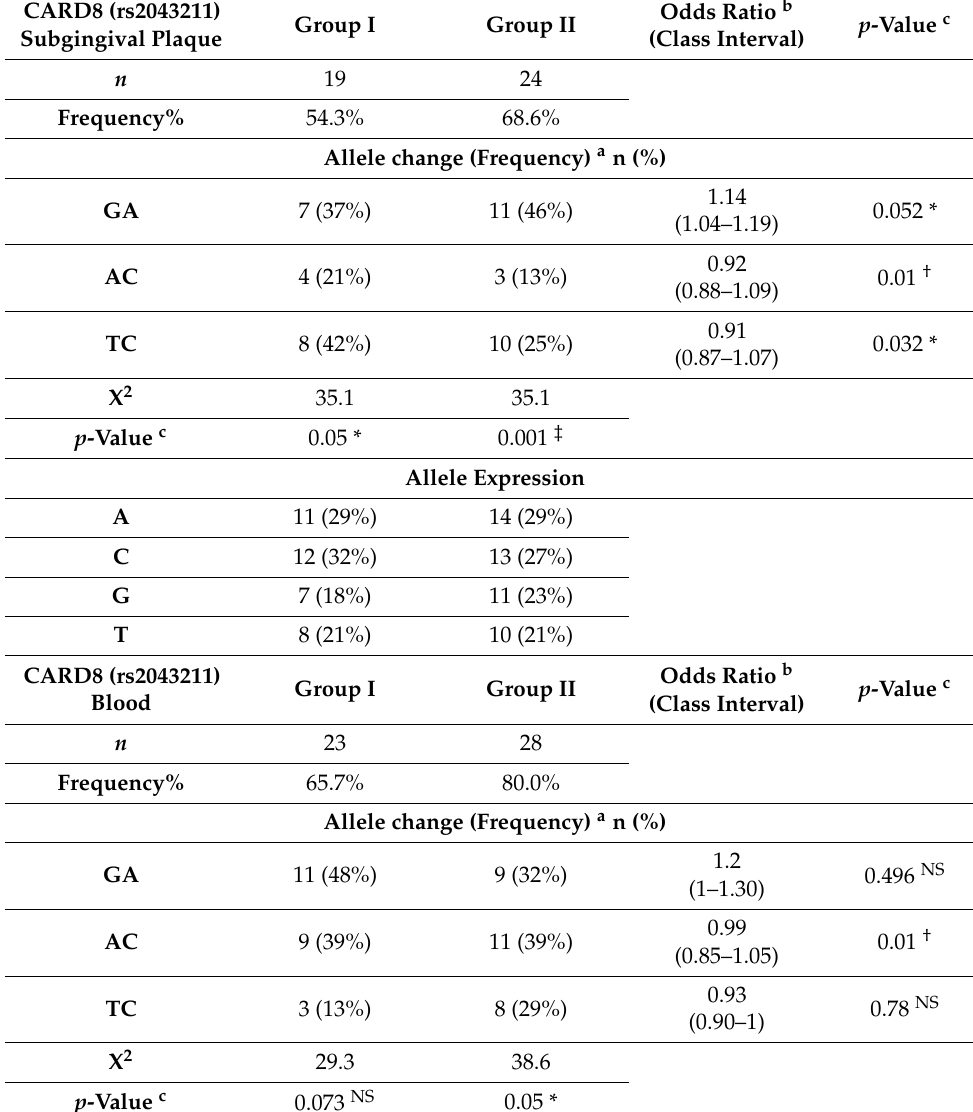
Table 4. Allele change (Frequency) of CARD8 (rs2043211) gene polymorphisms among Group I and Group II in subgingival plaque and blood